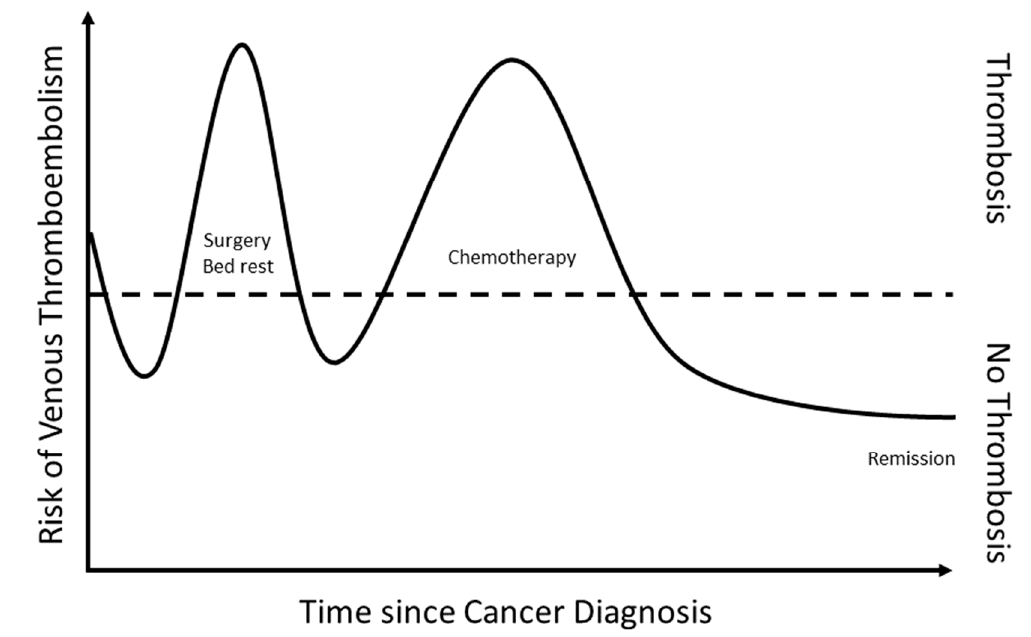
Figure 1. Overall risk for VTE throughout the course of cancer